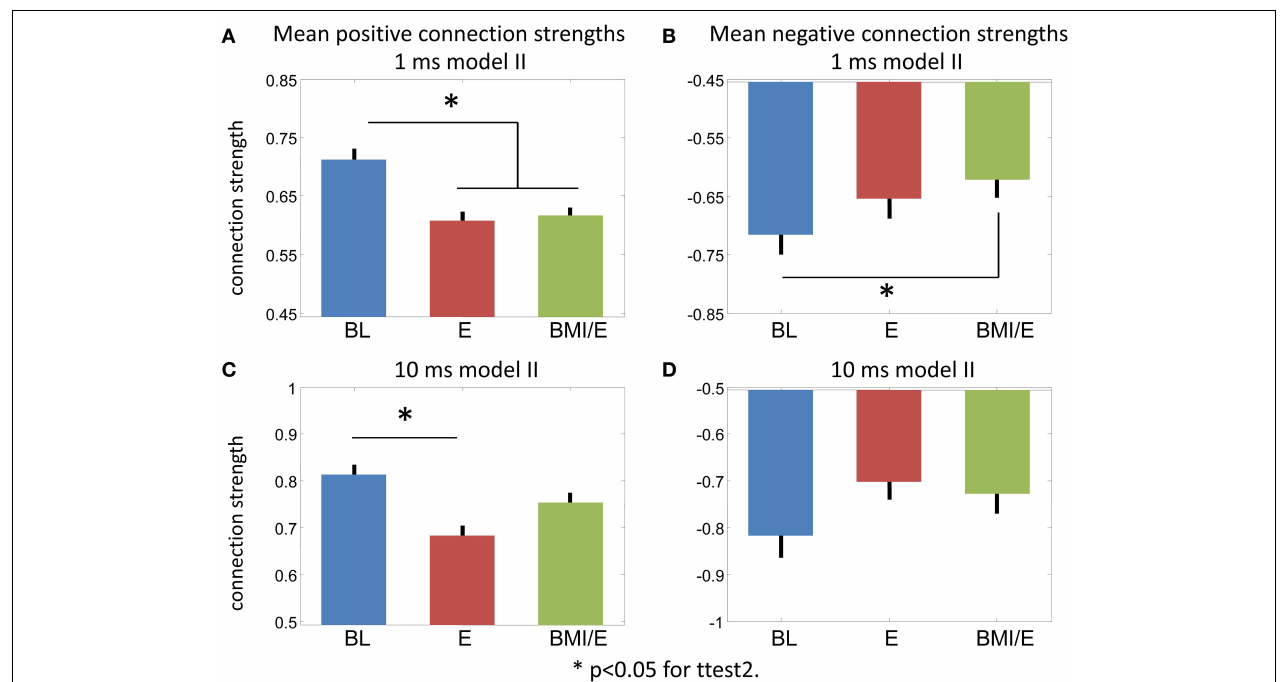
FIGURE 6 | Connection strength changes. (A,B) Model II 1ms bin fitting. (A) Positive connections. (B) Negative connections. (C,D) Model II 10ms bin fitting. ( C) Positive connections. (D) Negative connections. * Significant difference in a two-tailed t -test, p < 0 . 05 (MATLAB ttest2).